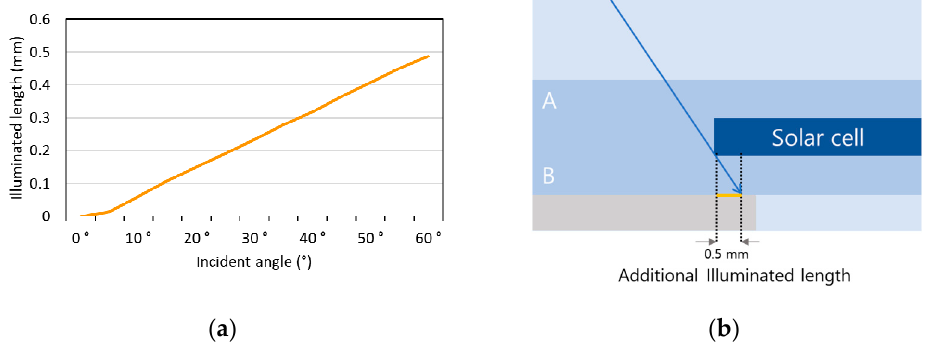
Figure 11. Additional illuminated length: ( a ) additional illuminated length based on incident angles; ( b ) maximum additional illuminated length.